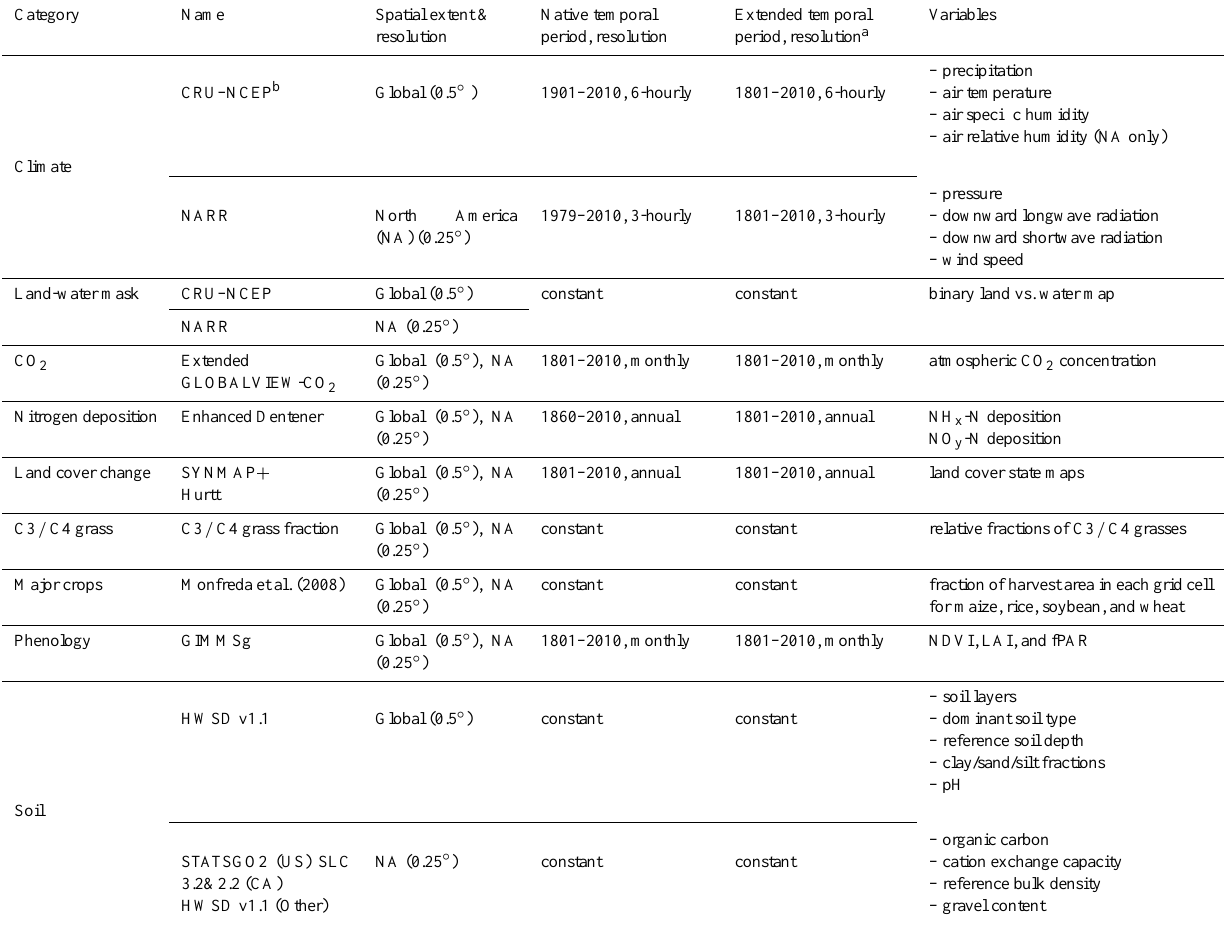
Table 1. The MsTMIP environmental driver data